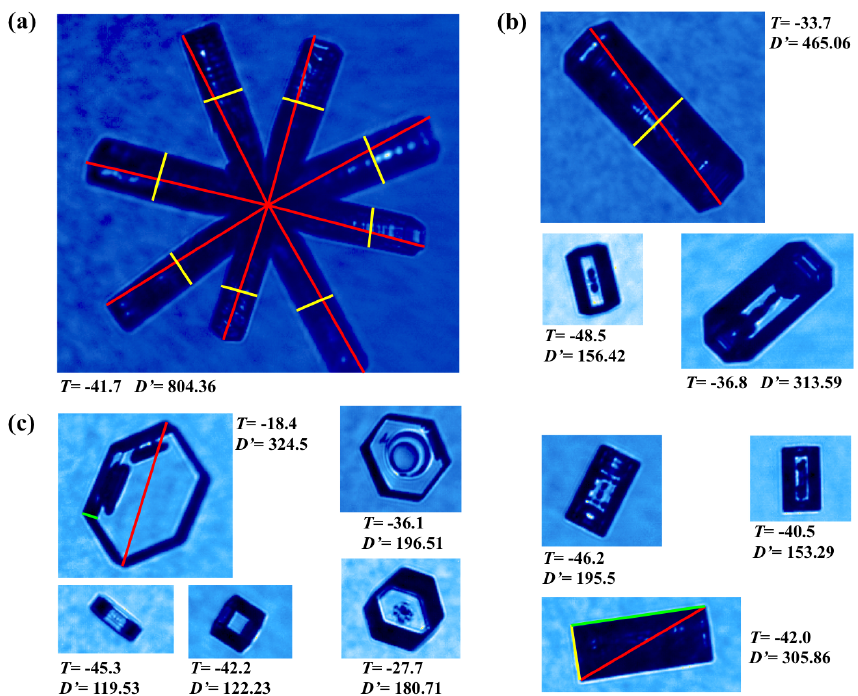
Figure 2. Example CPI images of ice crystals: (a) bullet rosette, (b) columns, and (c) plates taken during SPARTICUS. The projected maximum dimension ( D (cid:48) , red), projected width ( W (cid:48) , yellow), and projected length ( L (cid:48) , green), are indicated in the first crystal in each panel. For each crystal, temperature ( T , ◦ C) and projected maximum dimension ( D (cid:48) ,µm) are listed. For columns, the upper three images are columns with orientations, whereas the lower three are horizontally oriented with respect to the imaging plane.